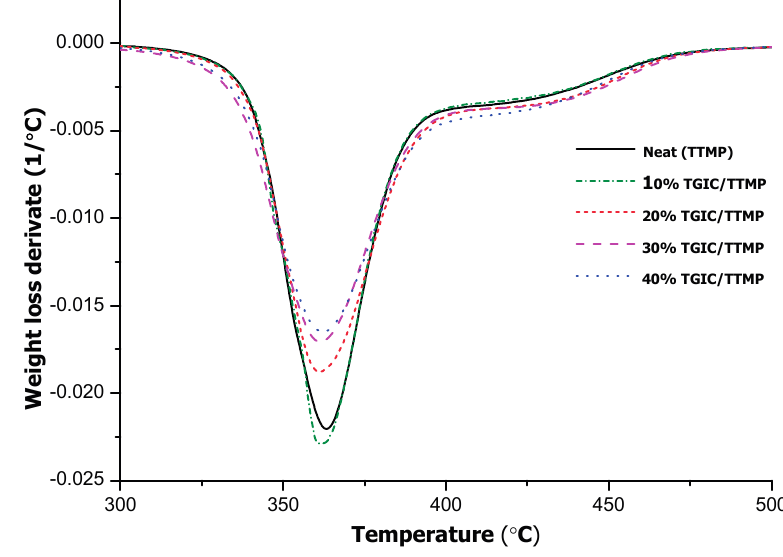
Figure 6. DTG (derivative of the thermogravimetric) curves registered under N 2 at 10 K/min of thermosets obtained from TTMP/TGIC/DGEBA